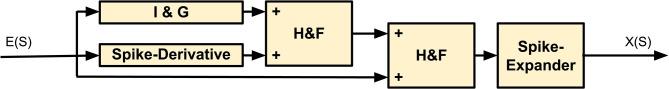
Spike-based PID controller created with SSP building blocks.